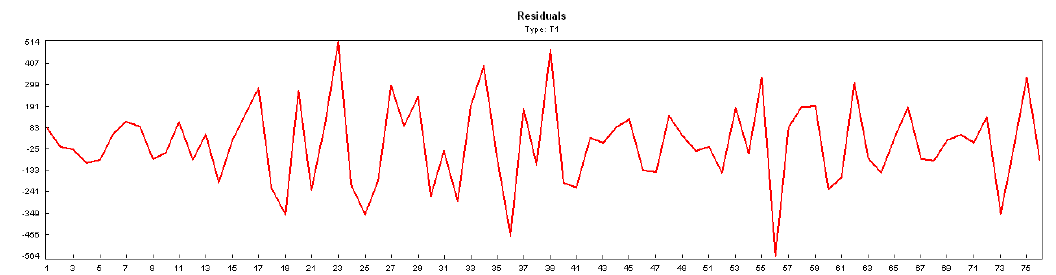
Figure 13. The residuals from the eigentriples 10 to 38.